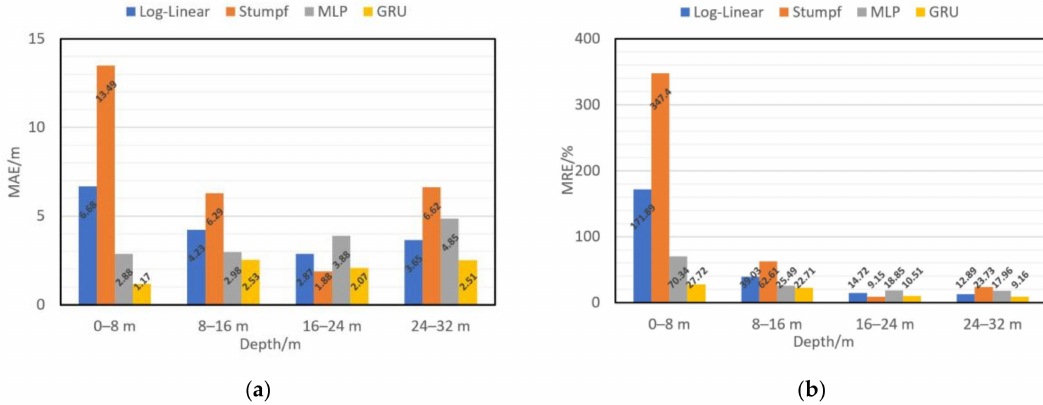
Figure 10. Inversion error statistics of di ff erent models at di ff erent water depth segments: ( a ) mean absolute error (MAE) of di ff erent models at di ff erent depth segments; ( b ) mean relative error (MRE) of di ff erent models at di ff erent depth